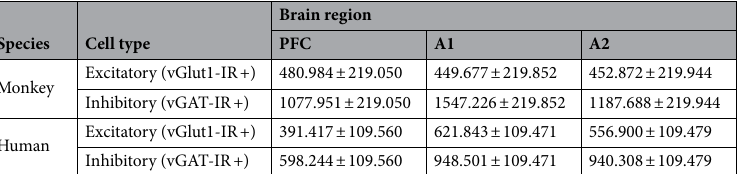
Table 2. CB1R mean intensity in analogue-to-digital units (ADU) across cell type and brain region for monkey and human samples. Values are represented as mean ± SEM. PFC = prefrontal cortex, A1 = primary auditory cortex, A2 = association auditory